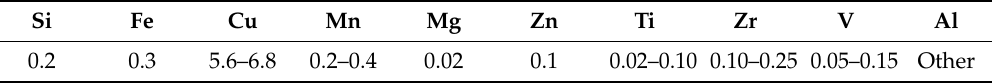
Figure 1. Schematics of the structure of the welded assembling. Table 1. Chemical composition of the 2219 Aluminum Alloy. (wt.%).